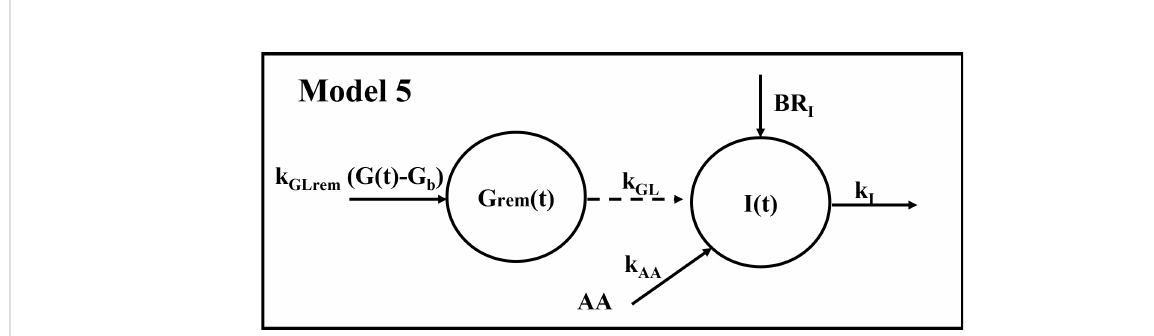
the same as in Model 1. Since in steady-state conditions all derivatives are equal to zero, BR I is the same computed for Model 1 and described in eq. (2). The model equation is: